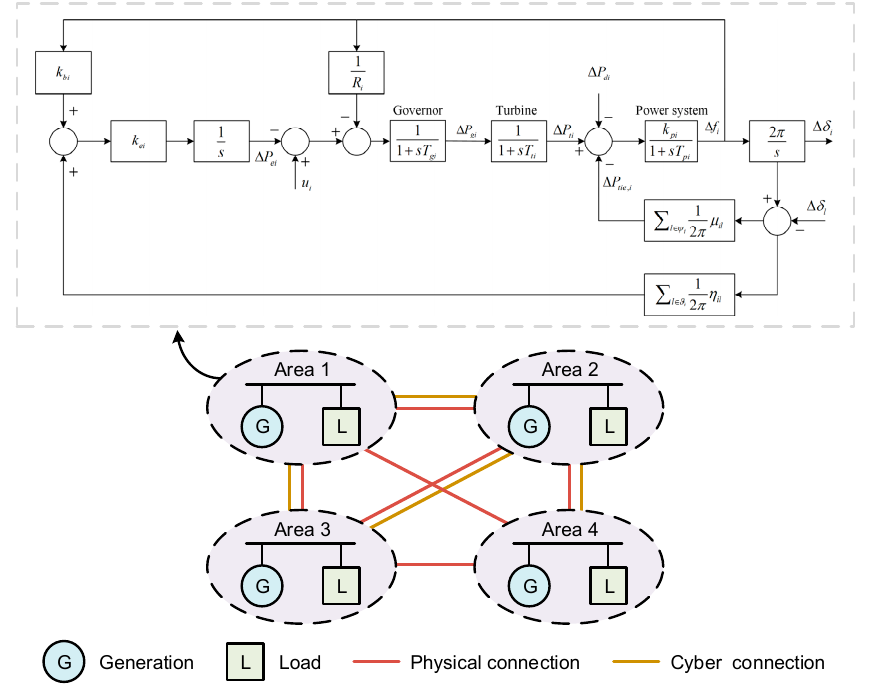
Figure 4. Working procedure of the approach for the frequency regulation of the multi − area power system.